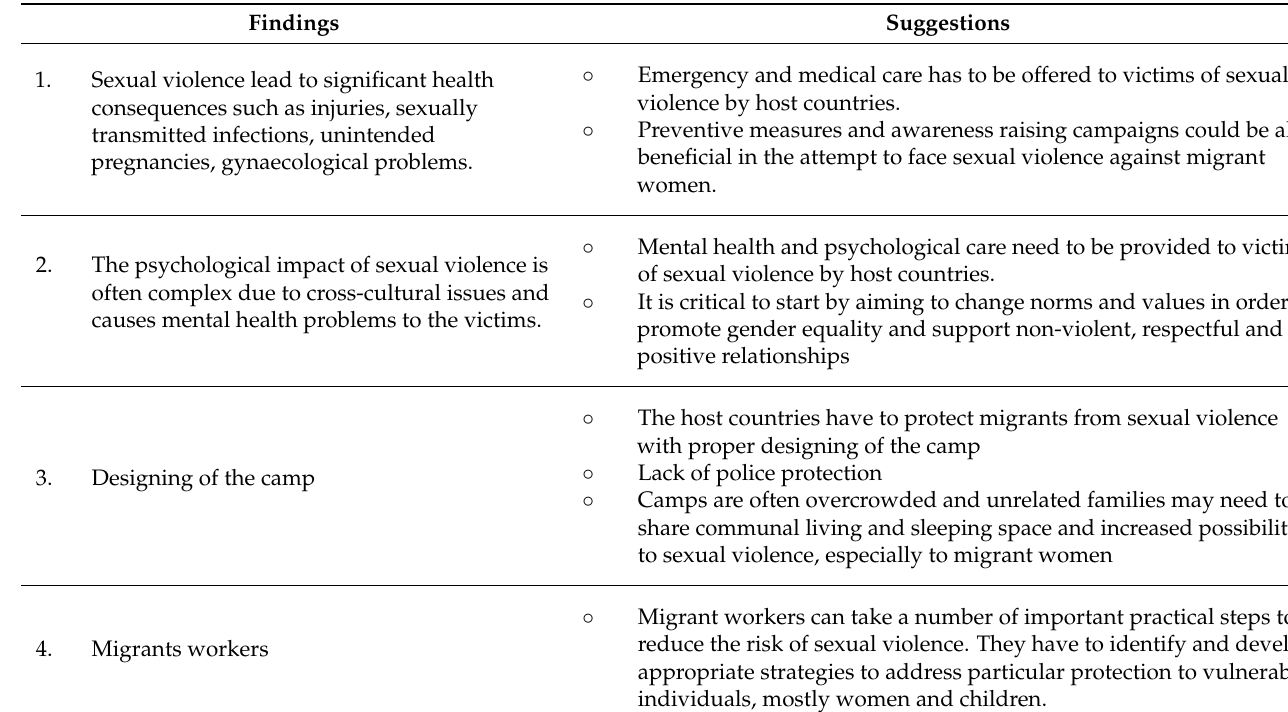
Table 2. Main findings of the study and